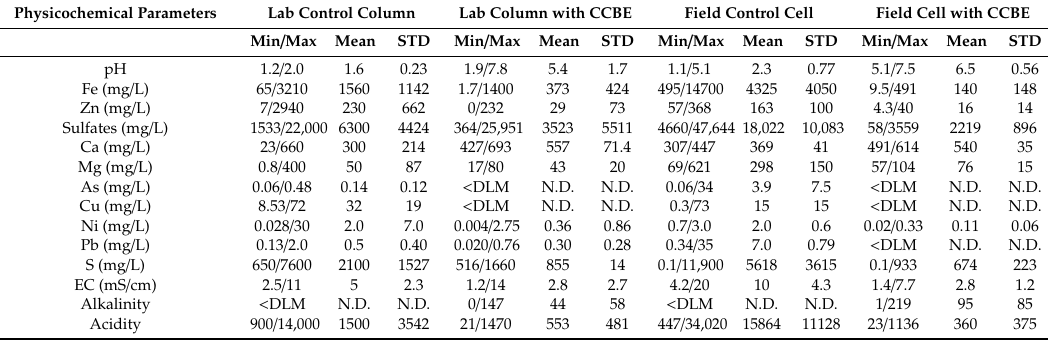
Table 4. Summary of the water quality results from laboratory control column, field control cell, CCBE column and cell.